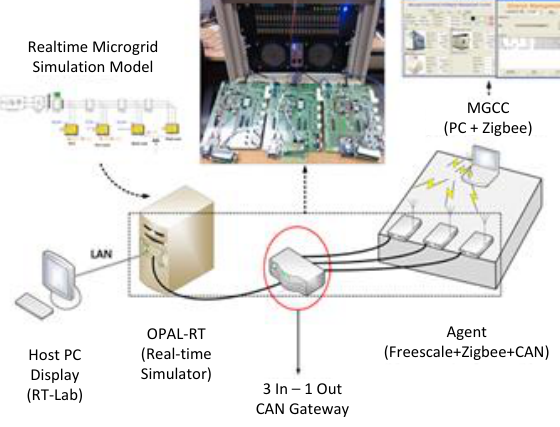
Figure 8. Hardware-in-the-loop (HILS) test configuration.